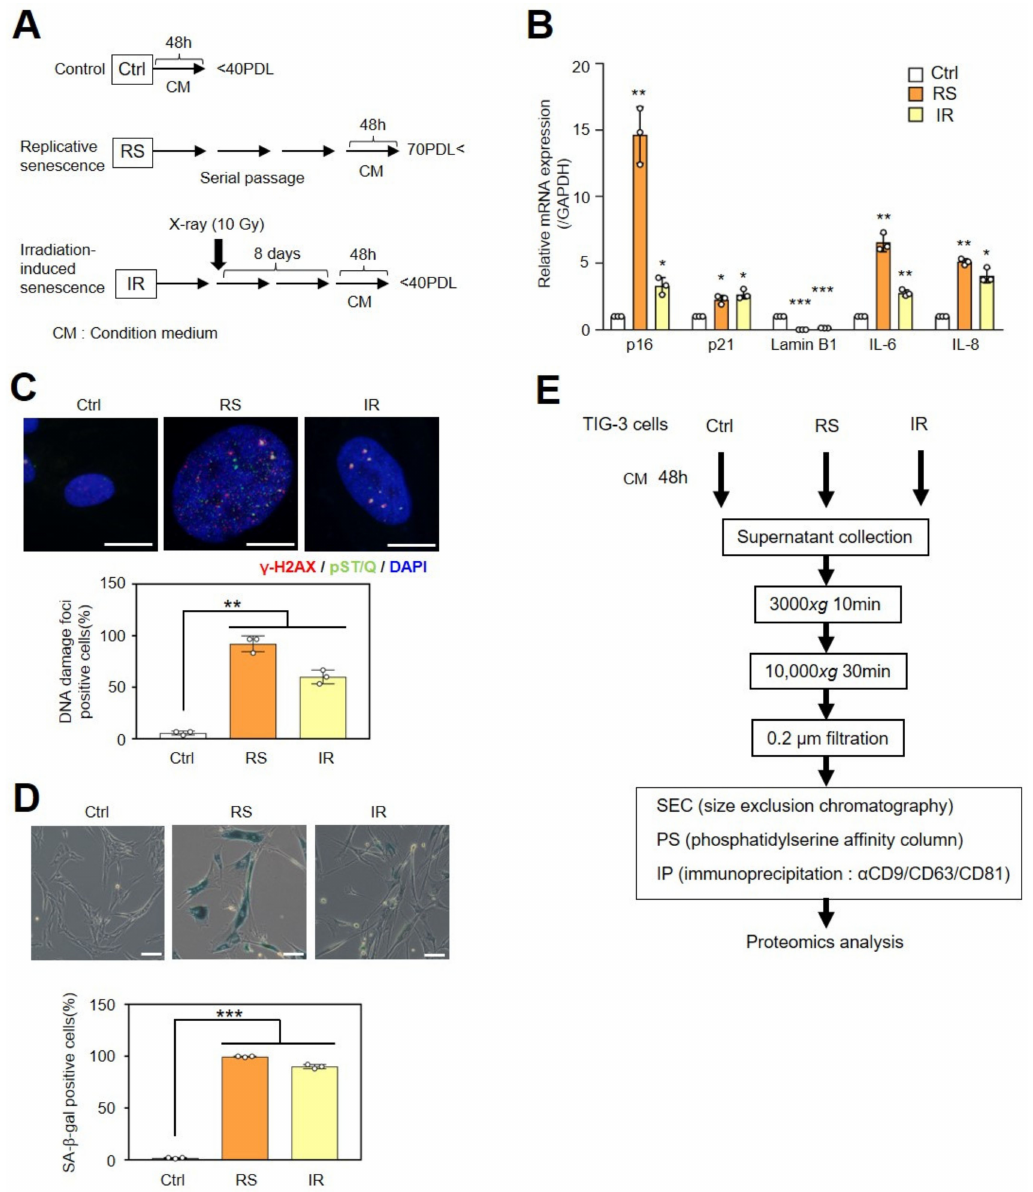
Figure 1. Collection of small EVs using three methods. ( A ) The timeline of senescence induction and medium collection using TIG-3 cells are shown. After induction of cellular senescence, control (Ctrl) and senescent cells (RS and IR) were cultured in conditioned medium (CM) for 48 h. ( B ) Relative mRNA levels of p16 INK4a , p21 WAF/CIP1 , lamin B1, IL-6, and IL-8 in control and senescent TIG-3 cells were detected using RT-qPCR. Relative quantitation data represent the mean ± standard deviation normalized to GAPDH. ( C ) Immunofluorescence staining with DNA damage markers, γ -H2AX (red), phospho-(Ser/Thr) ATM/ATR (pST/Q) substrate (green), and DAPI (blue). Scale bars = 20 µ m. Quantification of DNA damage-positive cells. The histograms indicate the percentage of nuclei containing more than two positive foci for both γ -H2AX and pST/Q staining from at least 100 cells per condition for three independent experiments. ( D ) Senescence-associated β -galactosidase (SA- β - gal) staining. The histograms indicate the percentage of SA- β -gal positive cells. Scale bars = 100 µ m. ( E ) The procedure for recovering sEVs from the CM uses three different collection methods. For all graphs, p -values were calculated by an unpaired two-tailed Student’s t -test (* p < 0.05, ** p < 0.01, or *** p < 0.001 by the unpaired two-sided t